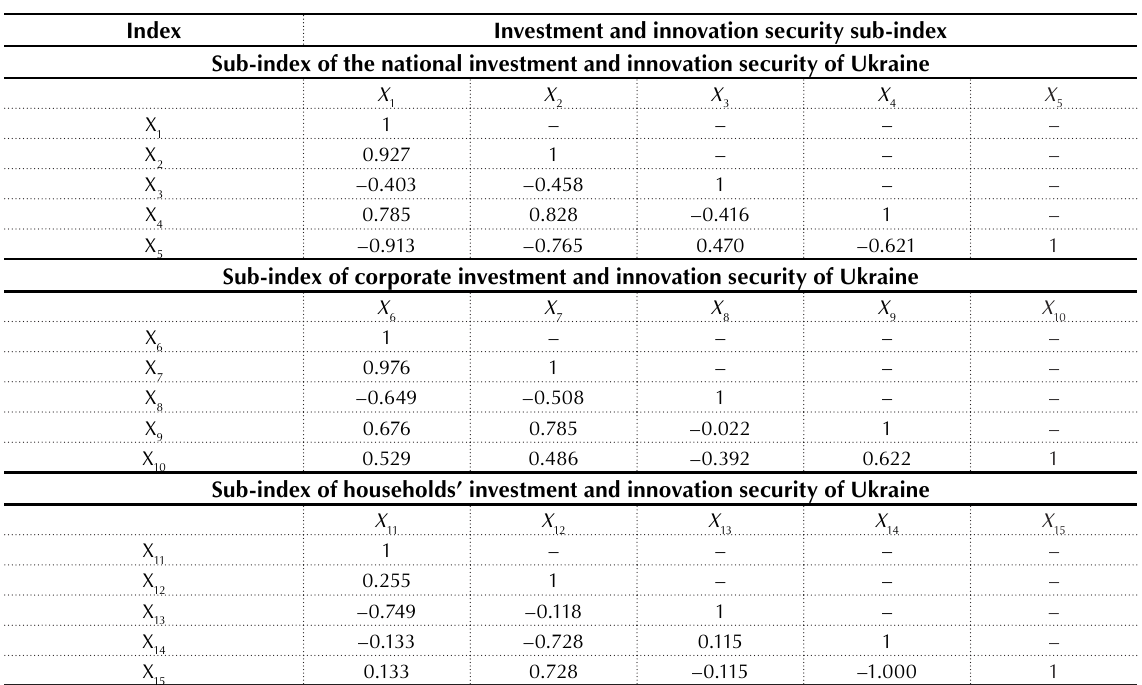
Table 4. Matrix of the paired correlation coefficients of single indices of the investment and innovation security